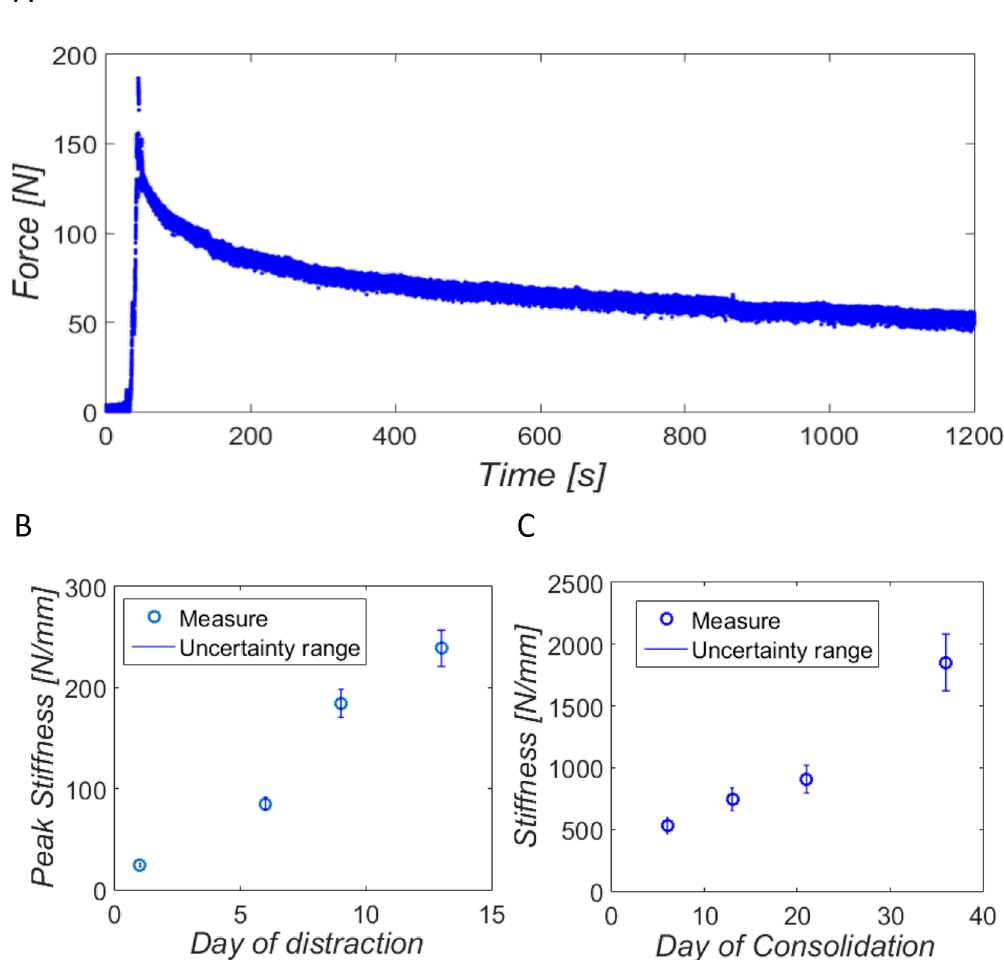
Figure 12. In vivo results: ( A ) distraction force measurement the ninth day of distraction of our specimen; ( B ) in vivo estimation of the peak stiffness of the bone callus at different time-points of the distraction phase and their uncertainty range; ( C ) estimation of the stiffness of the bone callus at different time-points of the consolidation phase and their uncertainty